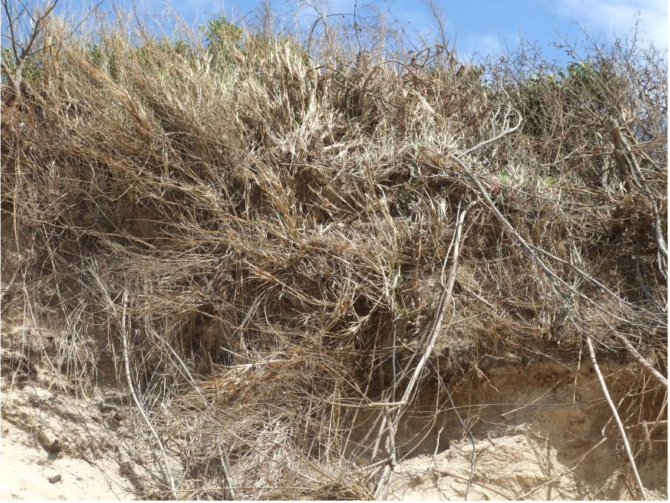
Figure 8. Moribund Ammophila arenaria with its erect rhizomes that grow up as the drift sands are